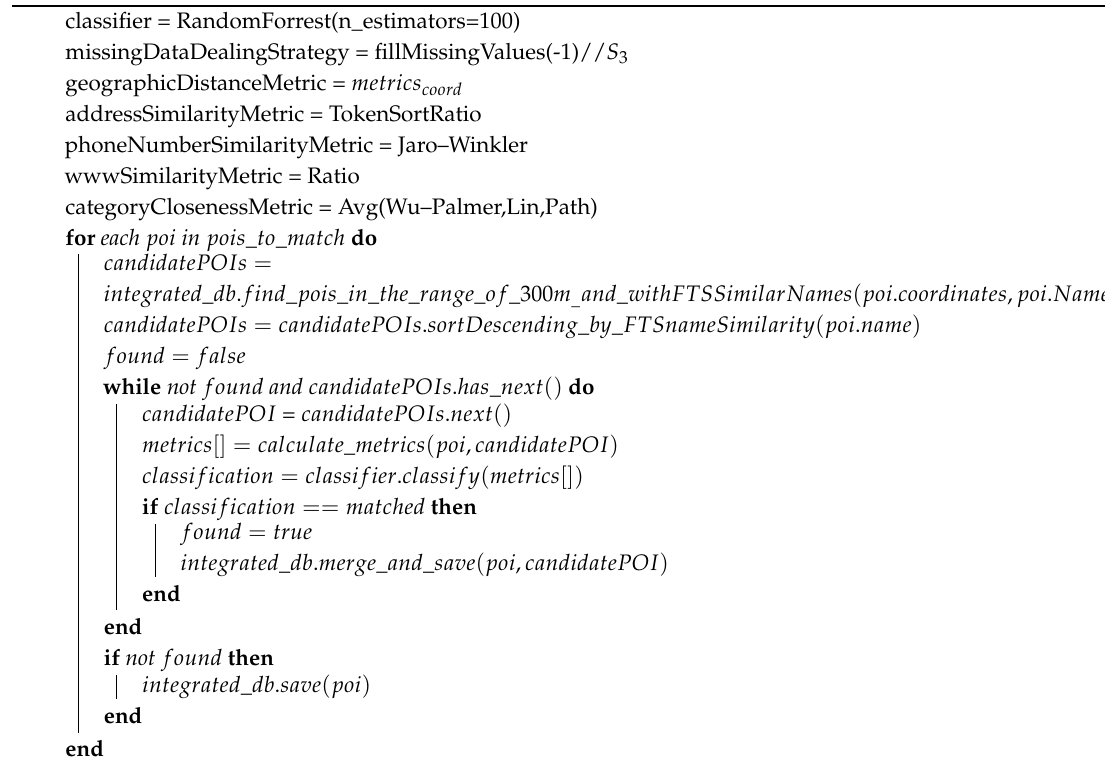
Algorithm 2: Automatic Points of Interest matching—greedy version.